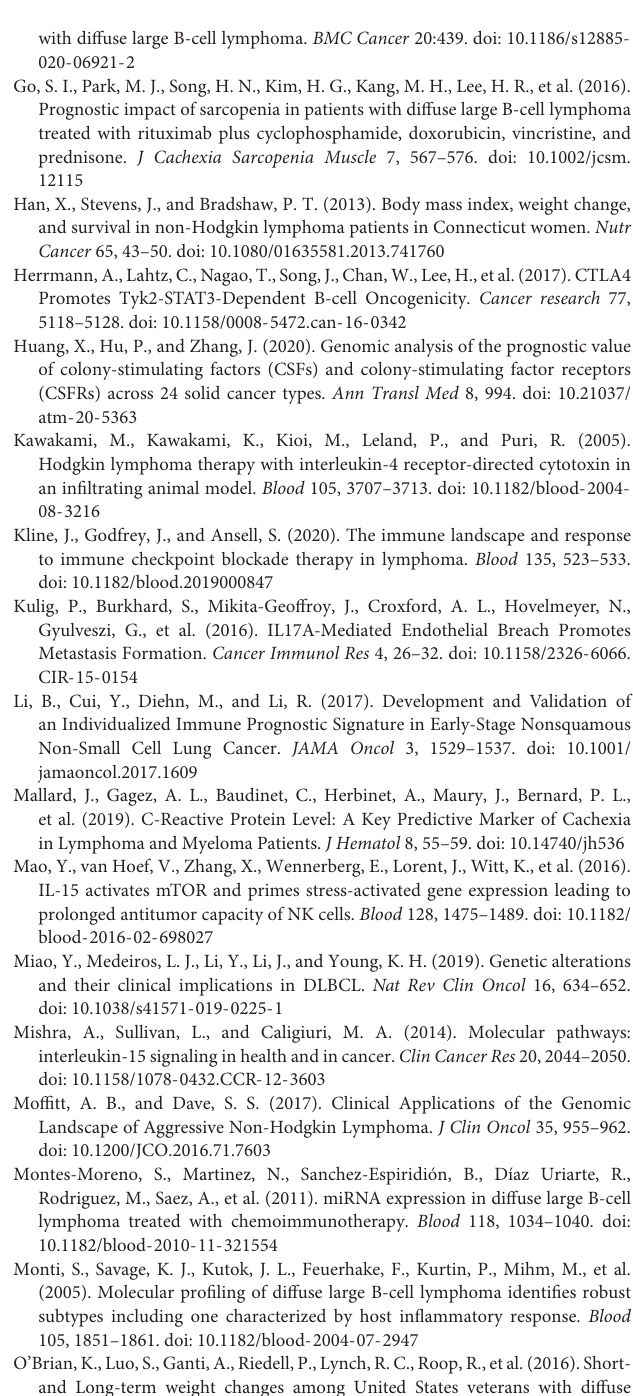
Supplementary Table 5 | consensus clustering analysisi results of 884 cases of DLBCL. Supplementary Table 6 | Estimating relative abundance of tumor microenvironment cells in 884 case of DLBCL patients by the Single-Sample Gene-Set Enrichment Analysis (ssGSEA). Supplementary Table 7 | 22 kinds of infiltrating immune cell composition which calculate by CIBERSORT analysis.